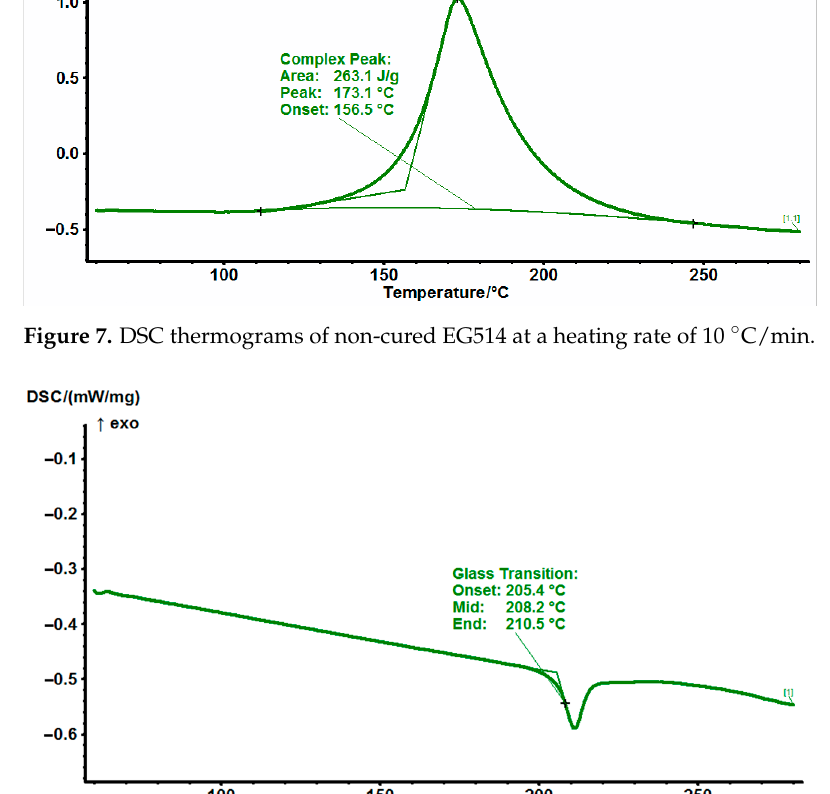
Figure 10. DSC thermograms cured EG531 at a heating rate of 10 °C/min. The results of DSC analysis for all three cured with MPD-TPA-MPD epoxy resins are presented in Table 2. As a result of the MPD-TPA-MPD use as a hardener, the T g for TGDMA and SER resins mixtures turned out to be quite similar with other previously studied hardener. With regard to DGEBA, the application of the new “green” hardener induced a significant increase in T g compared to other commonly used compounds. Table 2. T g of cured samples due to the DSC analysis. Sample